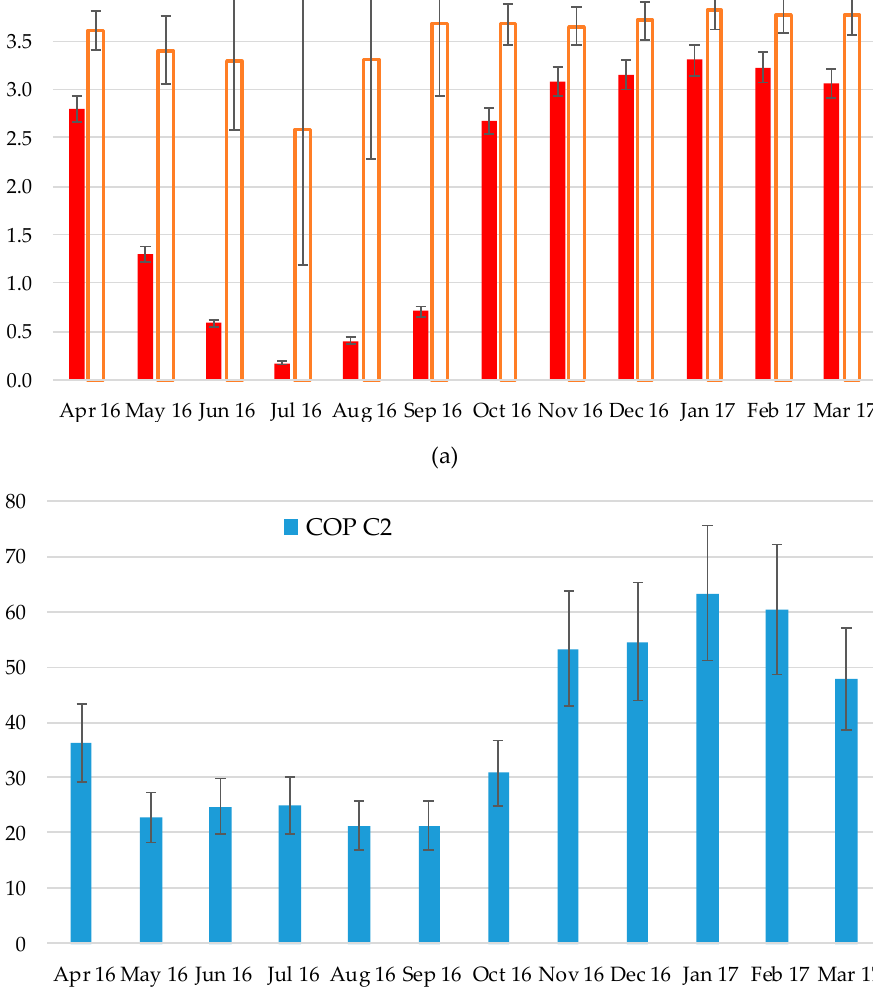
Figure 8. Monthly COP H2 and COP H3 ( a ) and COP C2 ( b ) with uncertainty bars, 1 April 2016 ‒ 31 March 2017.